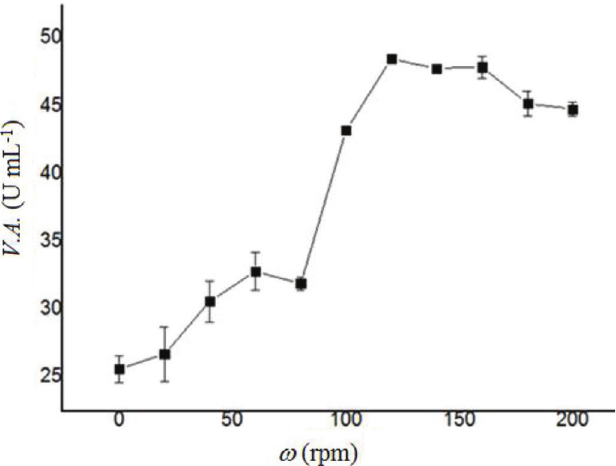
Fig. 4 – Effect of rotation rate on enzyme activity (with pH 6, alginate concentration 20 g L –1 , temperature 35 °C, and fermentation time 72